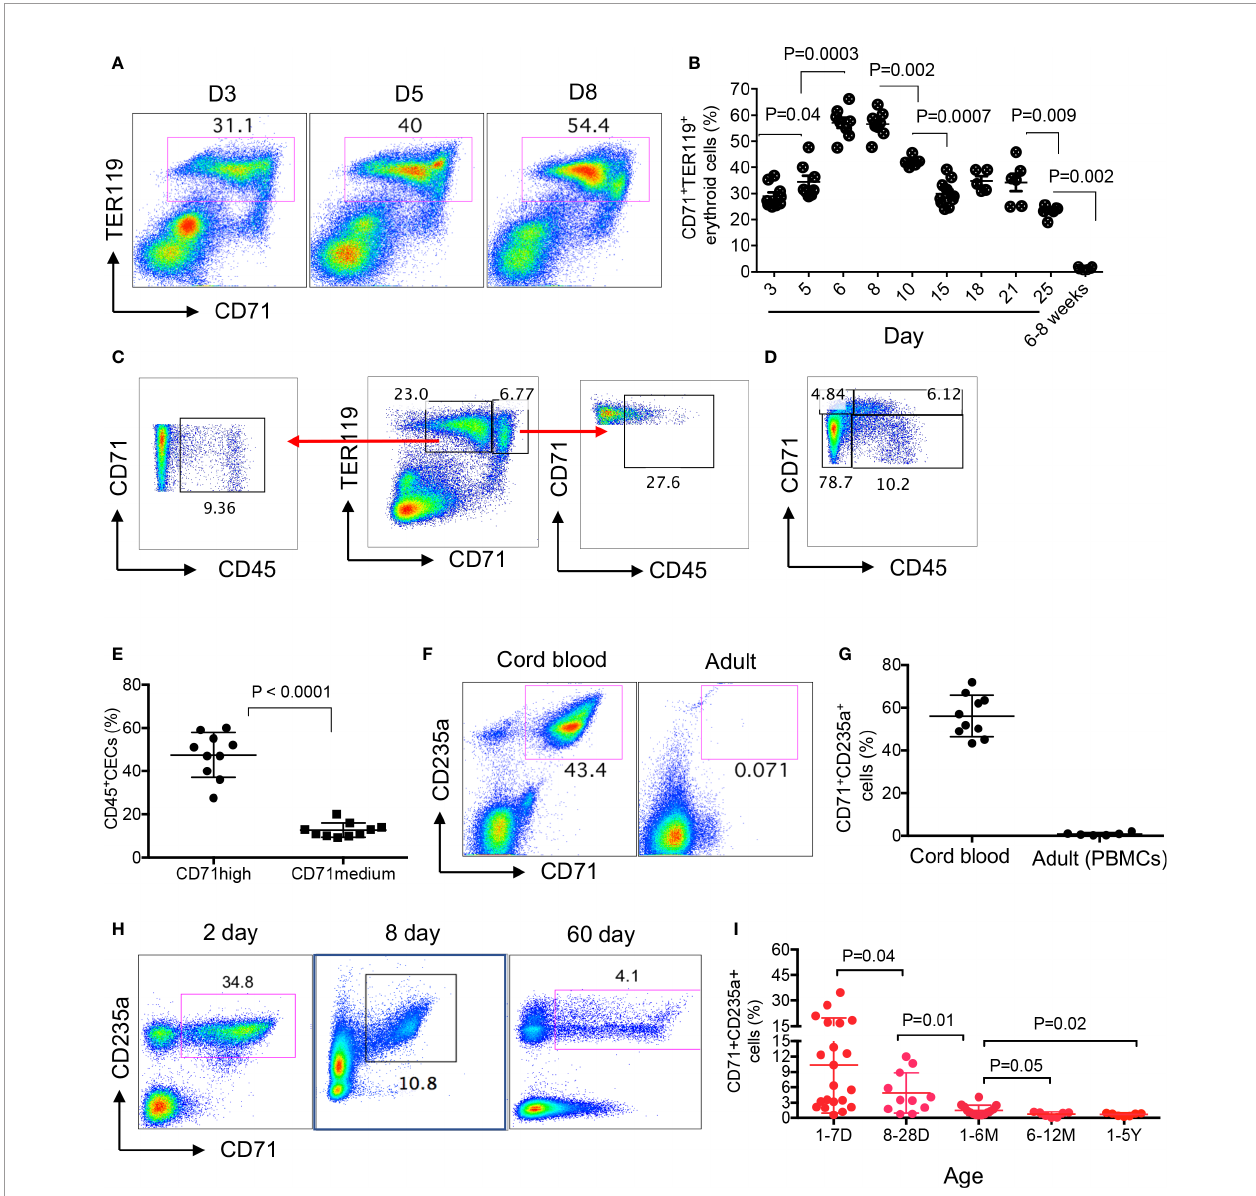
FIGURE 1 | Physiological abundance of CECs in newborns. (A) Representative fl ow cytometry plots of frequency of CECs in the spleen of days 3, 5, and 8 mice. (B) Cumulative data showing percentages of CECs in spleens of day-3 to adult (6 – 8 weeks) mice. (C, D) Representative plots showing percentages of CD45 + in TER119 + CD71medium and TER119 + CD71high CECs. (E) Cumulative data showing percentages of CD45+ subpopulation of CECs in TER119 + CD71medium and TER119 + CD71high CECs in the spleen of neonatal mice. (F) Representative plots of frequency of CECs in the cord blood or the peripheral blood of human adults. (G) Cumulative data showing the percentages of CECs in the cord blood versus the peripheral blood of adult humans. (H) Representative plots of frequency of CECs in the peripheral blood of human newborns (days 2 and 8 and 2 months). (I) Cumulative data showing the frequency of CECs in the peripheral blood of human infants/children from day 1 to 5 years of age. Each point represents data from an individual mouse or human subject (adult, cord blood, or neonatal blood). Bar, mean ± one standard